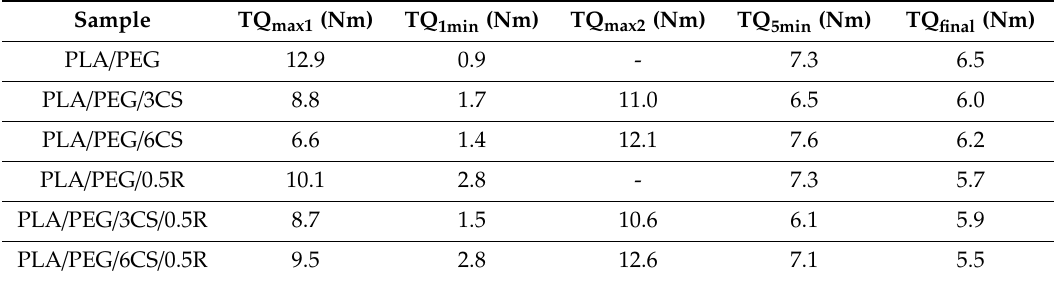
Table 3. Melt processing characteristics of PEG-plasticized PLA and its composites.